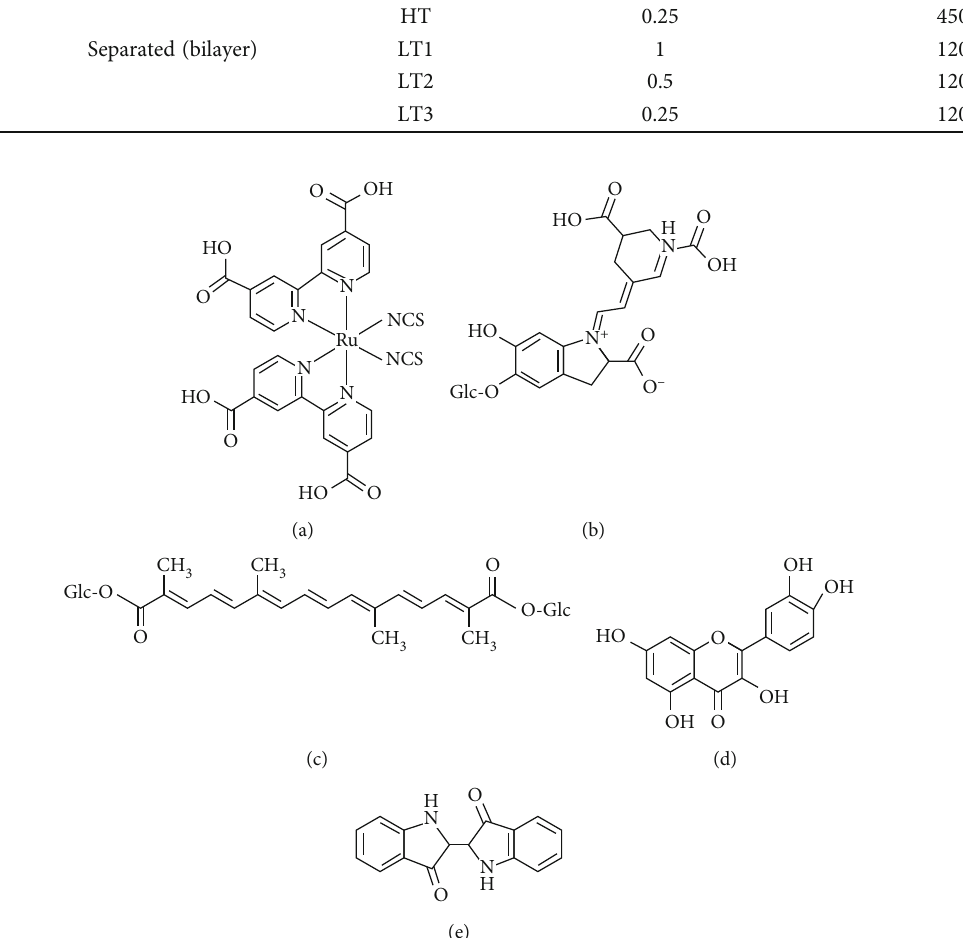
Figure 1: The chemical structure of (a) N719 [60], (b) betanin [18], (c) crocin [66], (d) acacetin [67], and (e) indigo